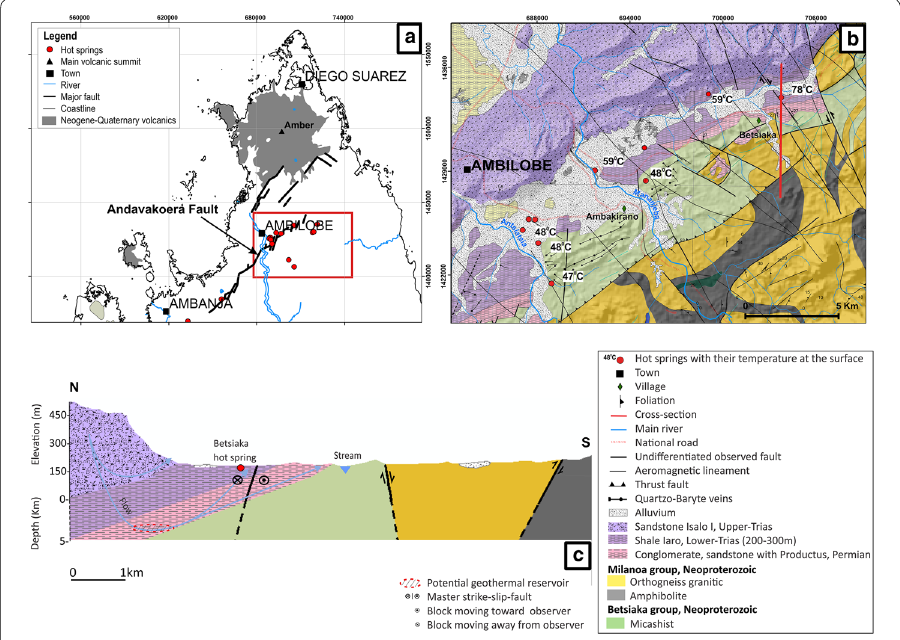
Fig. 2 a Location of Ambilobe geothermal area, b detailed geology showing the position of hot springs, modified from Roig et al. (2012), and c conceptual model of Ambilobe geothermal system in the Andavakoera fault zone. The vertical scale of the elevation profile, which was created using ASTER(Advanced Spaceborne Thermal Emission and Reflection Radiometer) imagery, has been exaggerated compared to the depth scale, which is based on the structure of the crust and uppermost mantle beneath Madagascar (Andriampenomanana et al.